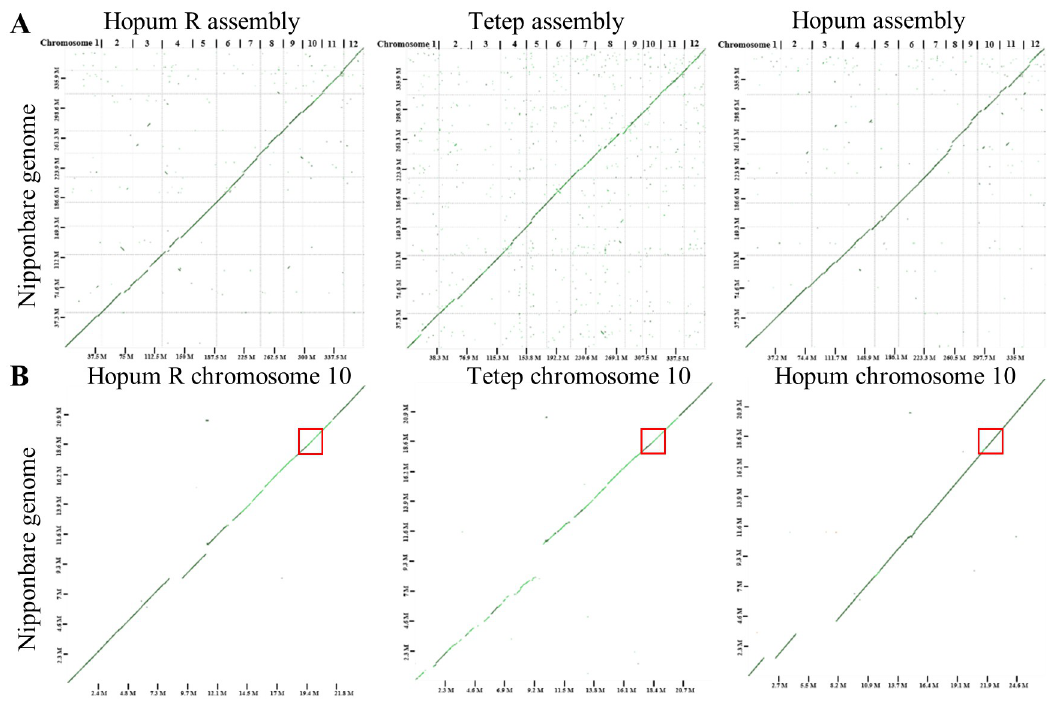
Fig 4. D-GENIES dot plots showing the syntenic relationships between Nipponbare reference genome and the assembled genomes. (A) All chromosome of Hopum R, Tetep, and Hopum. (B) Only chromosome 10. Red box indicates the genomic region of interest.